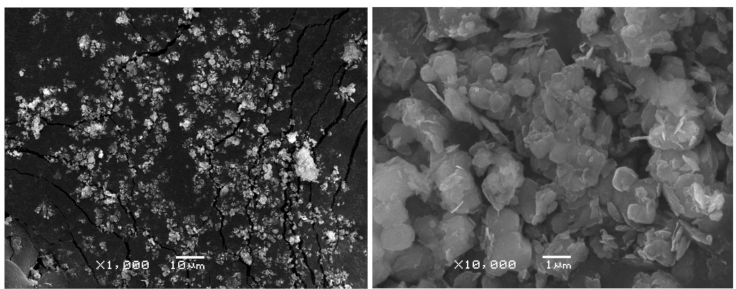
Figure 12. SEM image of red